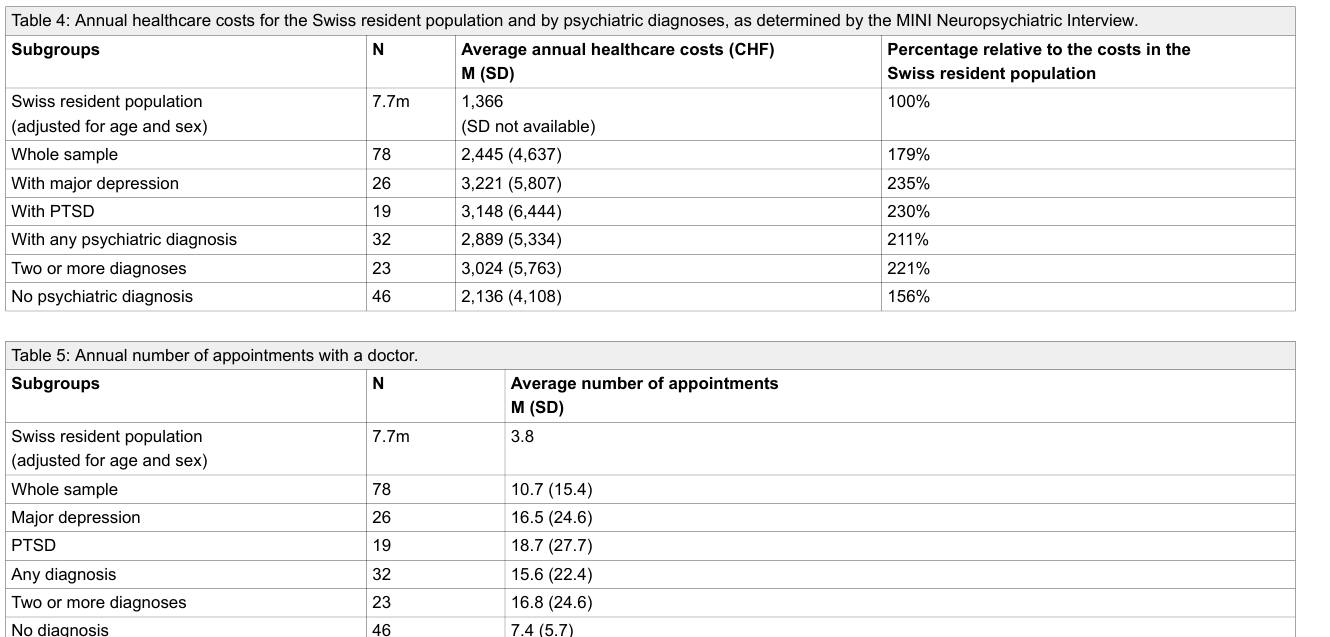
Percentage relative to the costs in the Swiss resident population